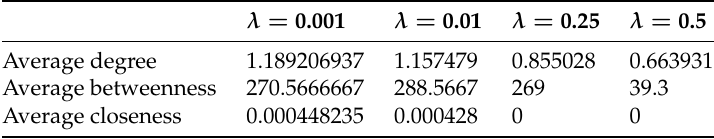
Table 4. Average centralities across different lambda